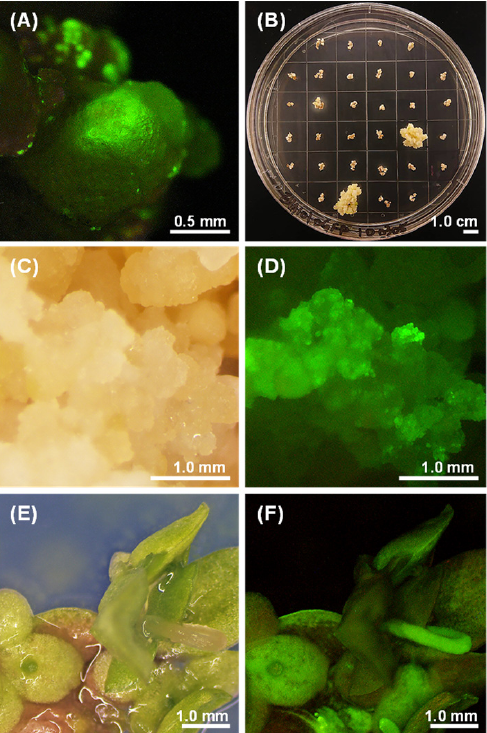
Figure 3. Stable transformation and regeneration of L. aequinoctialis callus with a GFP expression construct. ( A ) Transformed nodular calli showed GFP expression under selection medium at day 9; ( B ) newly divided calli were observed after 10 weeks of selection; ( C ) newly divided calli were observed under bright-field and ( D ) GFP channel with long-pass filter; ( E ) transformed fronds were observed under bright-field and ( F ) GFP channel with long-pass